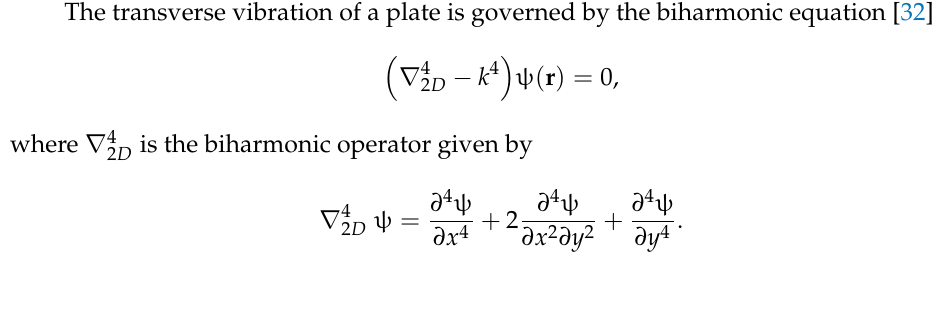
Figure 4. ( a ) Eigenvalue with the coupling parameter α for a specific case of k the eigenfunctions on the parameter α . ( c ) Nodal-line patterns corresponding to the wave patterns in ( b ). ( d ) Contribution of original eigenfunctions ψ n , m ( r ) in the perturbed eigenfunction Ψ ( r ; k )